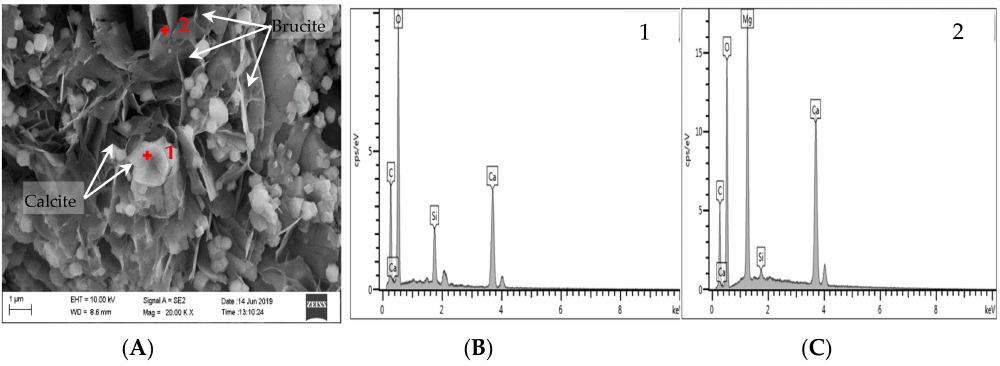
Figure 16. SEM and EDS images of products in concrete bars cured in 1 mol / L TMAH at 80 ◦ C: (A) SEM image of the products; (B) EDS image of calcite; (C) EDS image of